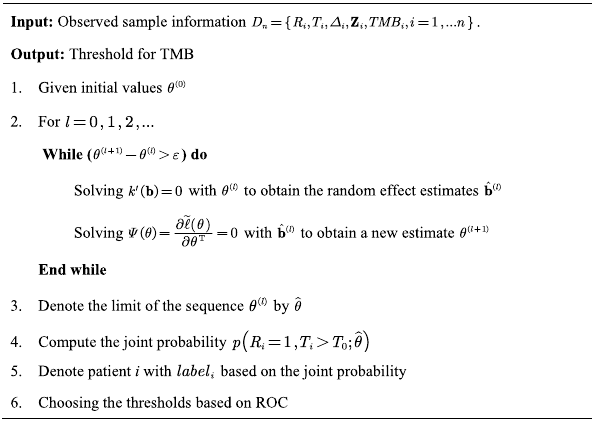
Algorithm 1. Identifying TMB threshold without measurement